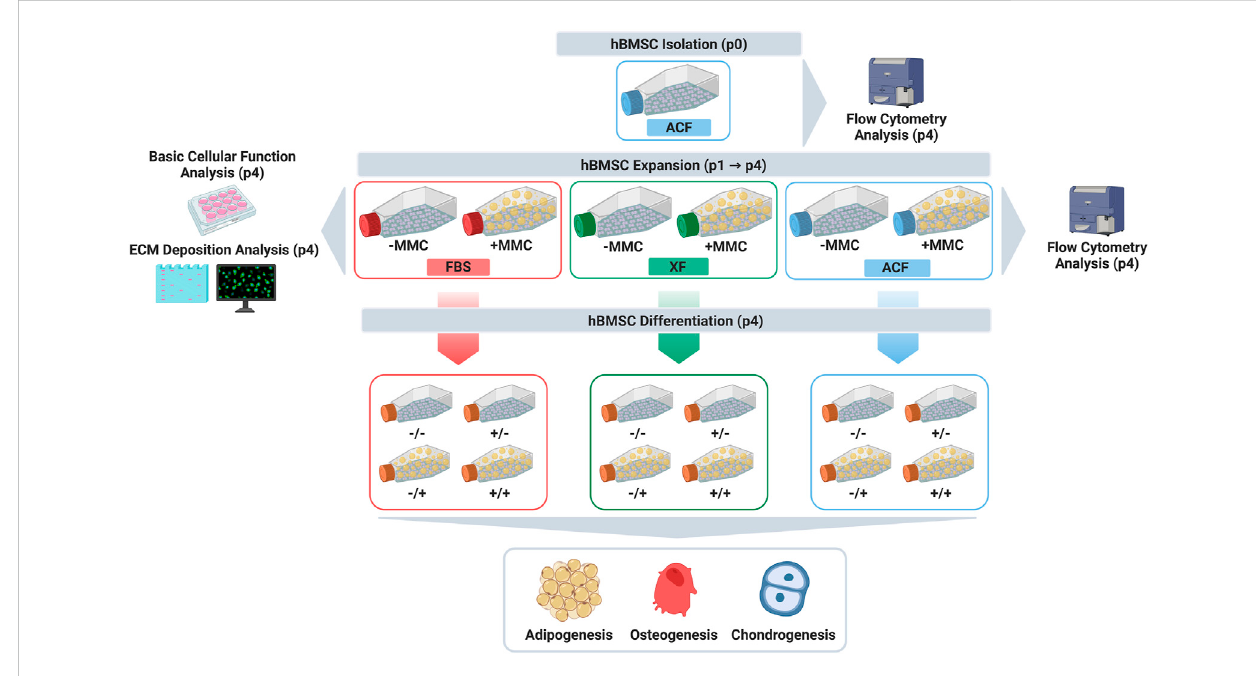
FIGURE 1 Study design. Created with